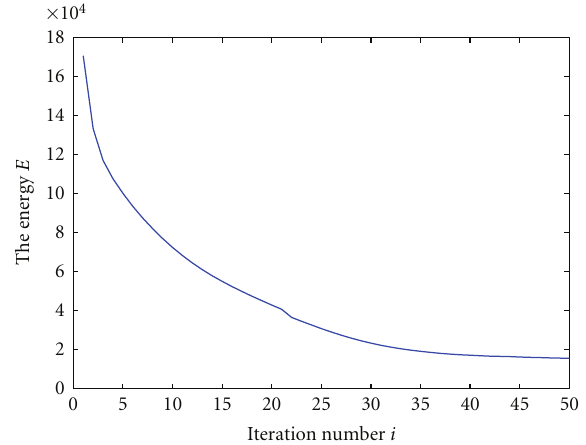
Figure 5: Energy change with the iteration.